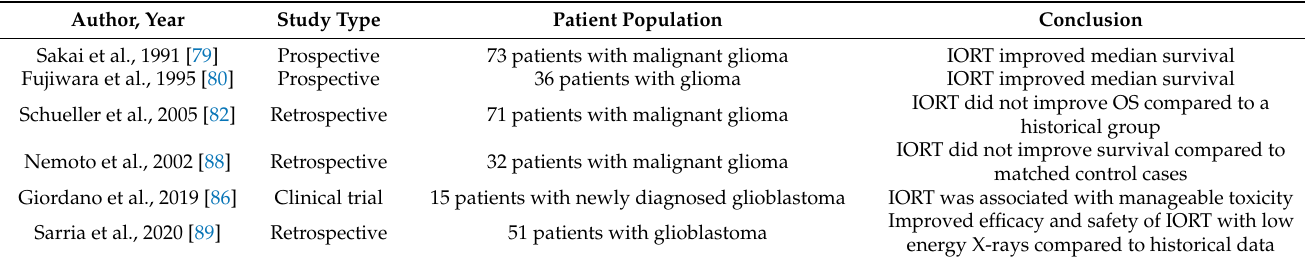
Table 5. Main studies evaluating the use of IORT in patients with brain